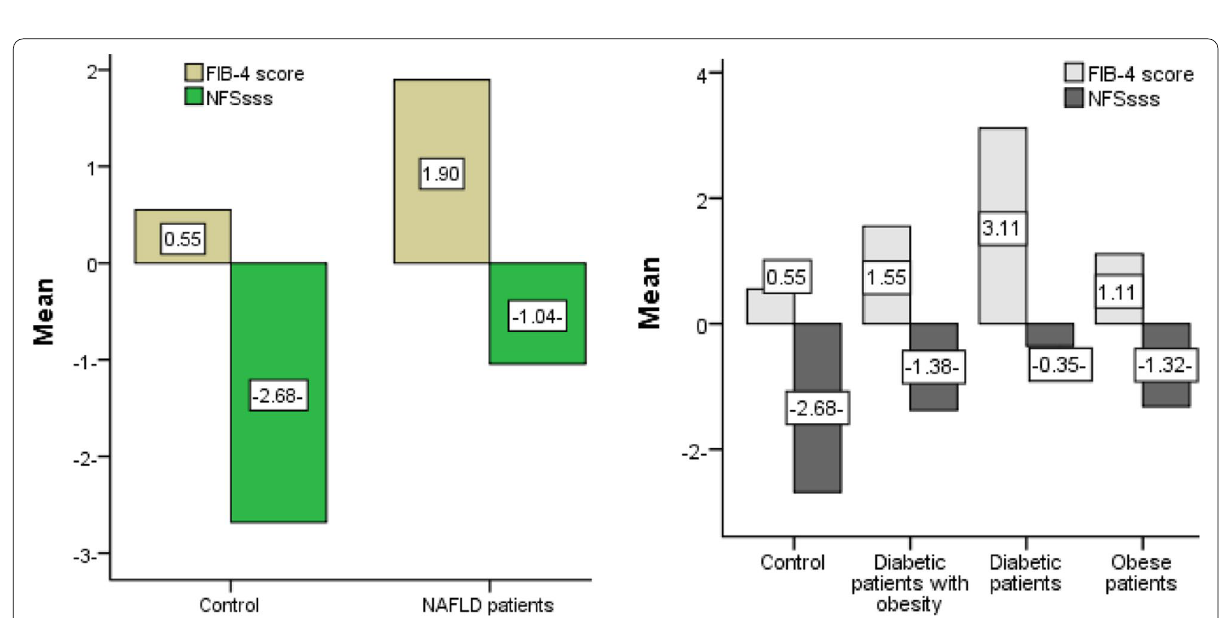
Fig. 3 Comparison between all studied groups as regard to NFS and FIB-4